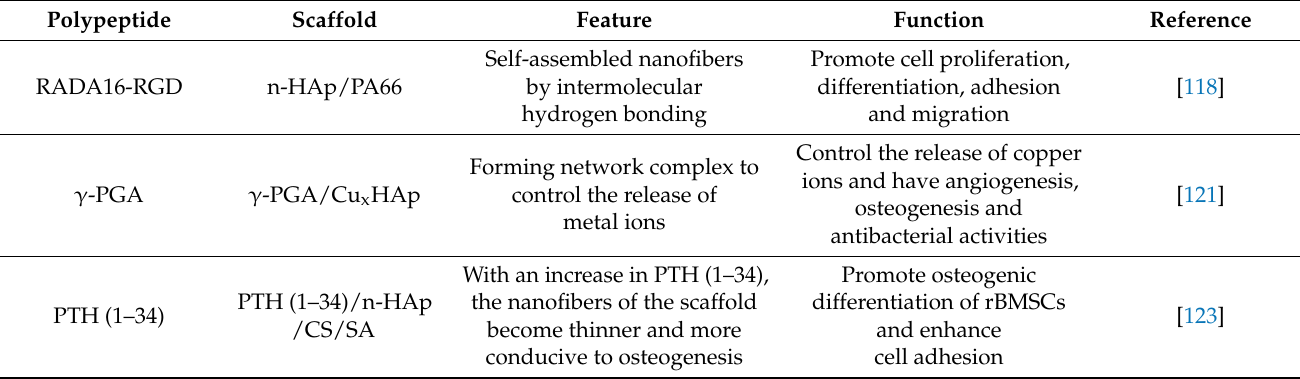
Table 3. Summary of polypeptide-loaded n-HAp composites for bone